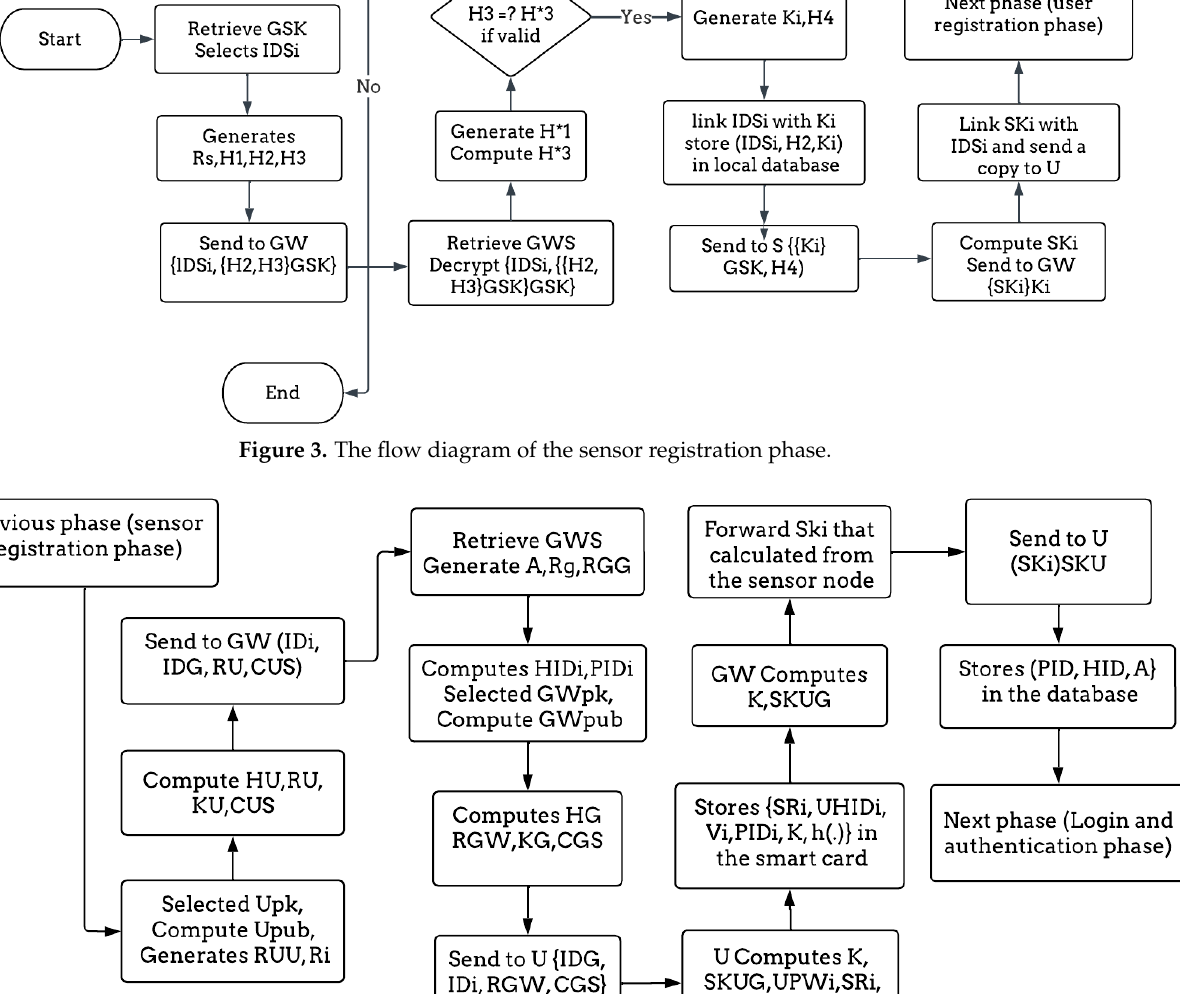
Figure 4. The flow diagram of the user registration phase.